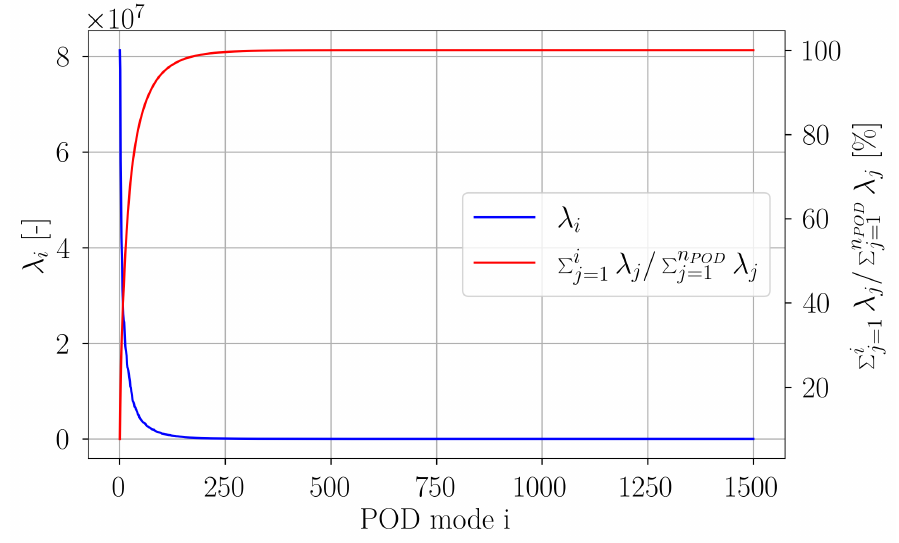
Figure 20. Contribution of POD modes to the total fluctuation kinetic energy and the cumulative portion of POD modes to the total fluctuation kinetic energy.